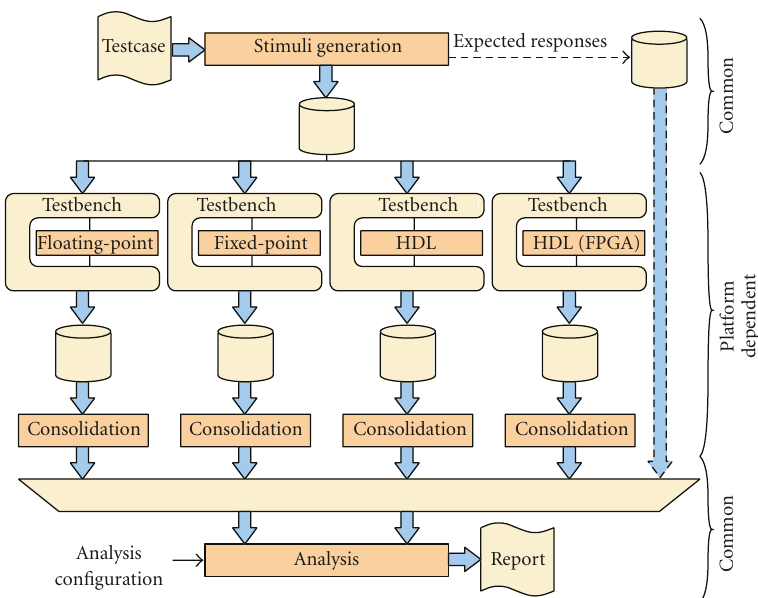
Figure 3: Top-Level Verification Flow.